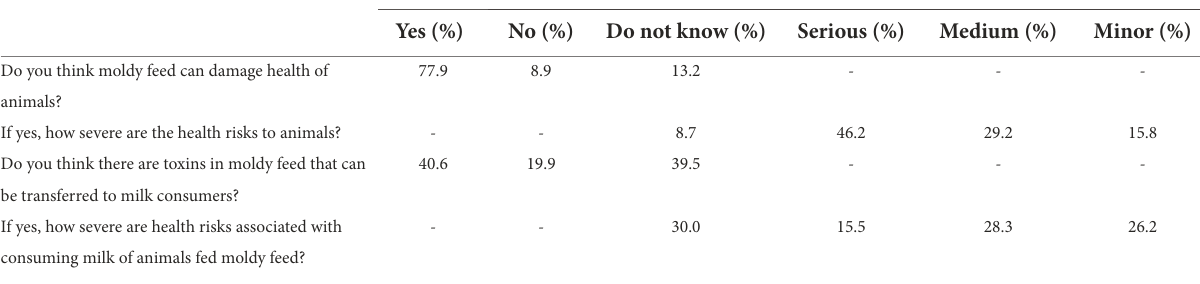
TABLE 3 Knowledge of farmers about moldy feed and its negative health